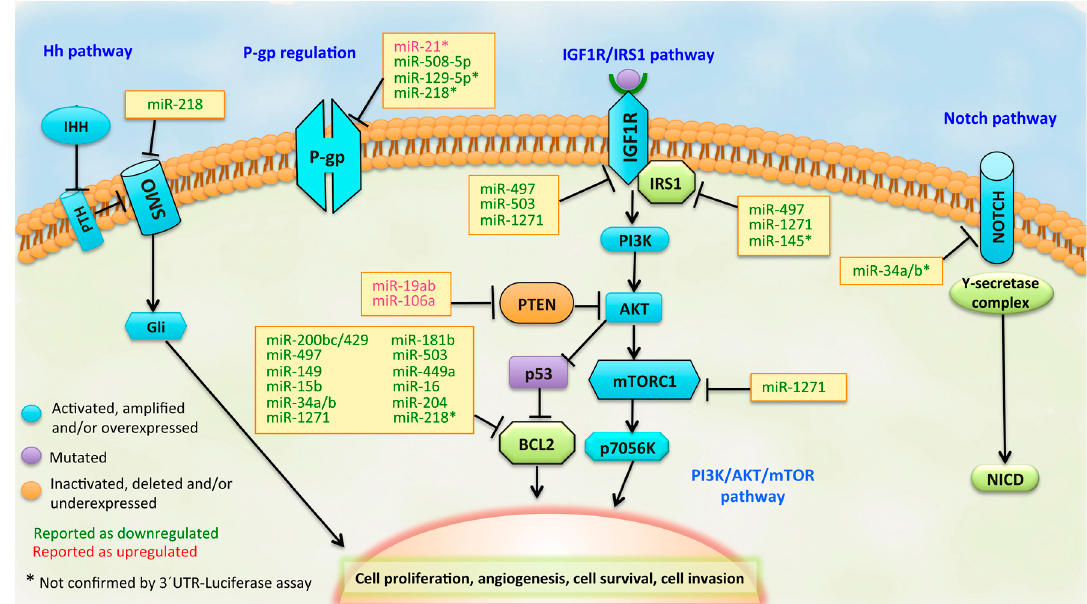
Figure 1. Pathways that represent potential targets for miRNAs in drug-resistant GC. The components of each signaling pathway are colored according to their dominant alteration type (see the key at the lower left). In the yellow boxes, the miRNAs are listed, including those downregulated (green letters) and those upregulated (red letters) in GC.